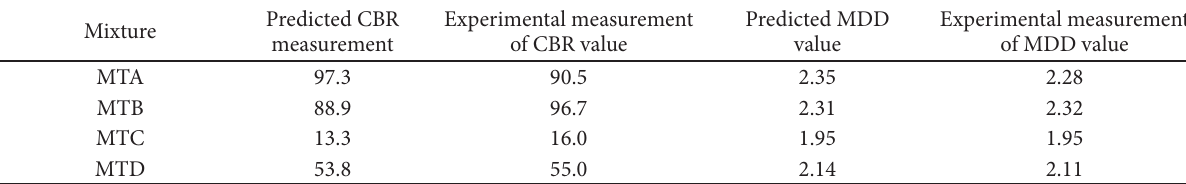
Table 7. Experimental measures of CBR and MDD values for the validation mixtures